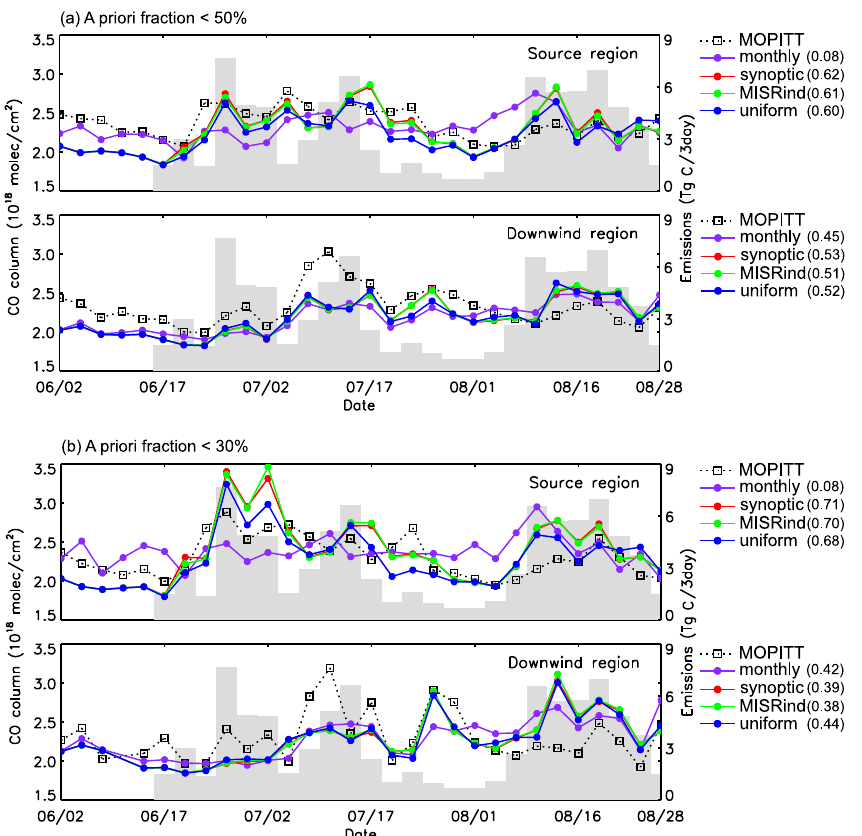
Fig. 11. Time series of mean CO column (10 18 molec/cm 2 ) in a source domain (150 ◦ –110 ◦ W, 55 ◦ –70 ◦ N) and a downwind domain (110 ◦ – 60 ◦ W, 50 ◦ –70 ◦ N) from MOPITT retrievals and GEOS-Chem simulations. Each point represents a value of three-day average CO column. Locations of these domains are shown in Fig. 10. MOPITT averaging kernel and the a priori CO profile were applied to model results. The correlation coefficients between MOPITT and model simulations are shown in the legend. Two a priori thresholds (50% and 30%) were used to filter out samples with large a priori contributions. Grey bars represent total biomass burning emissions (TgC/3-day) in the